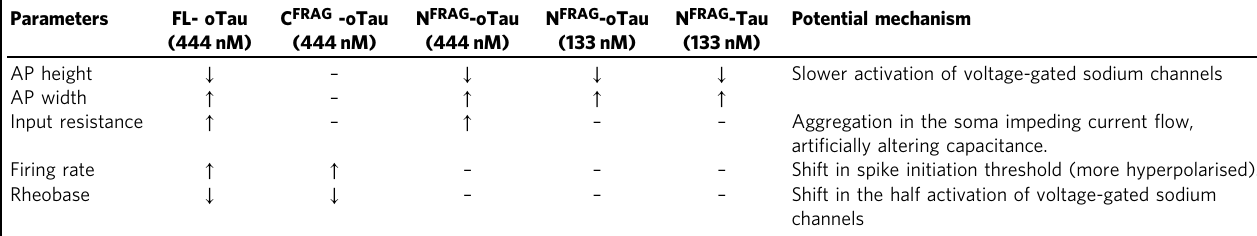
Table 2 Summary of fi ndings using recombinant truncations of tau and the identi fi ed mechanisms. Parameters